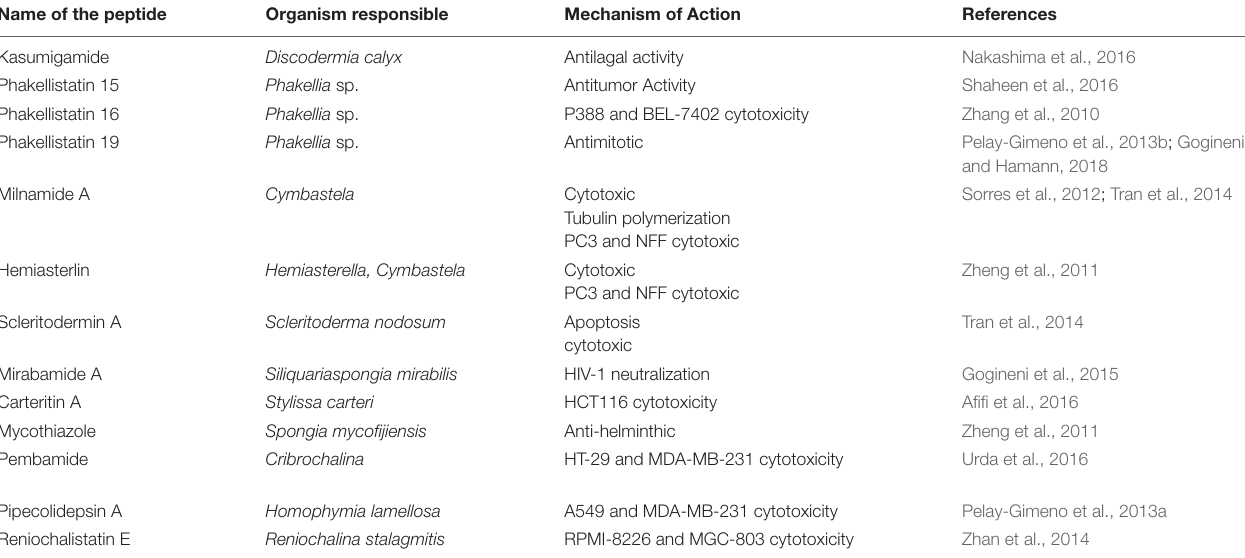
TABLE 2 | Marine microbial-derived peptides with different